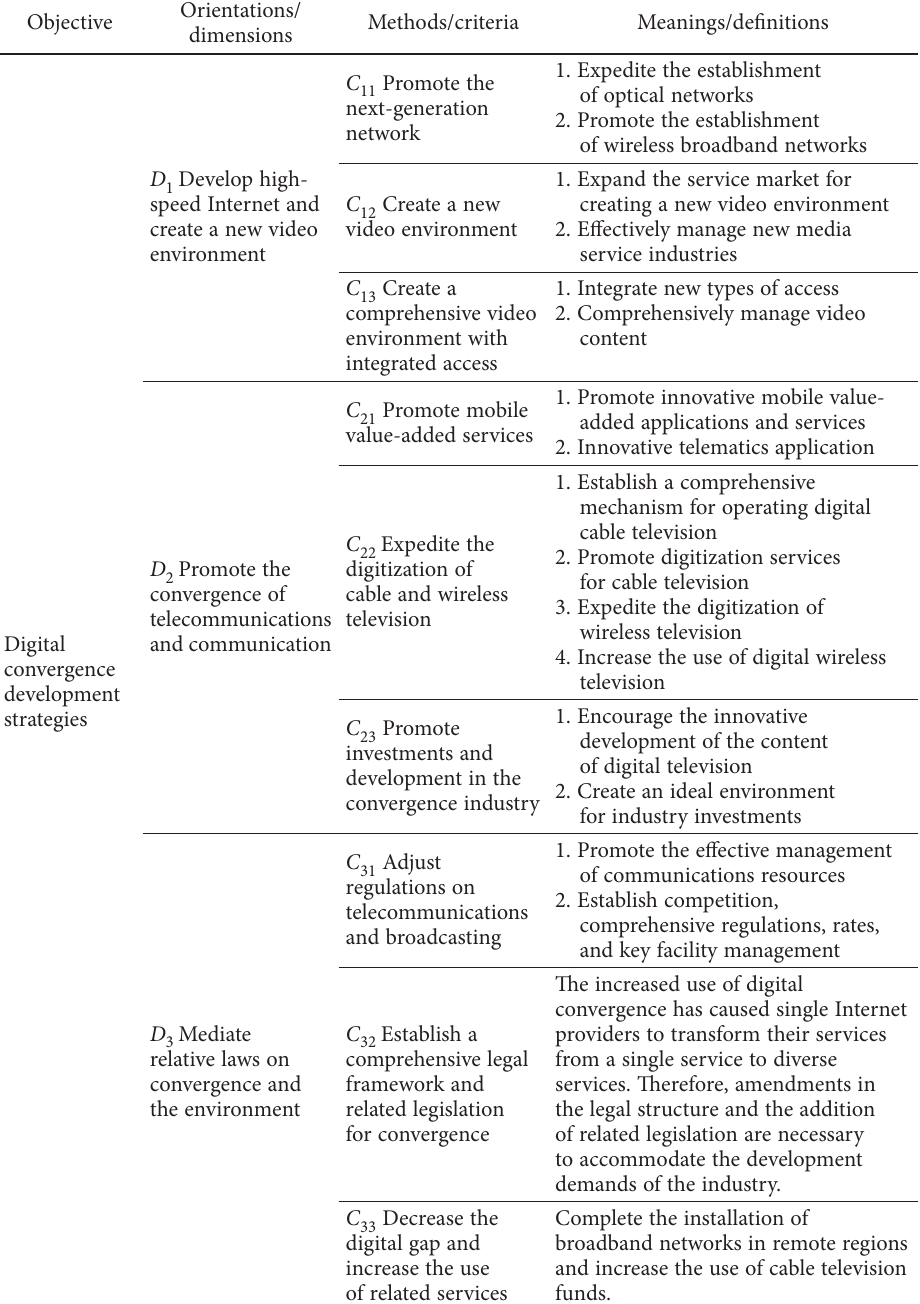
Table 1. Digital convergence development strategies in Taiwan